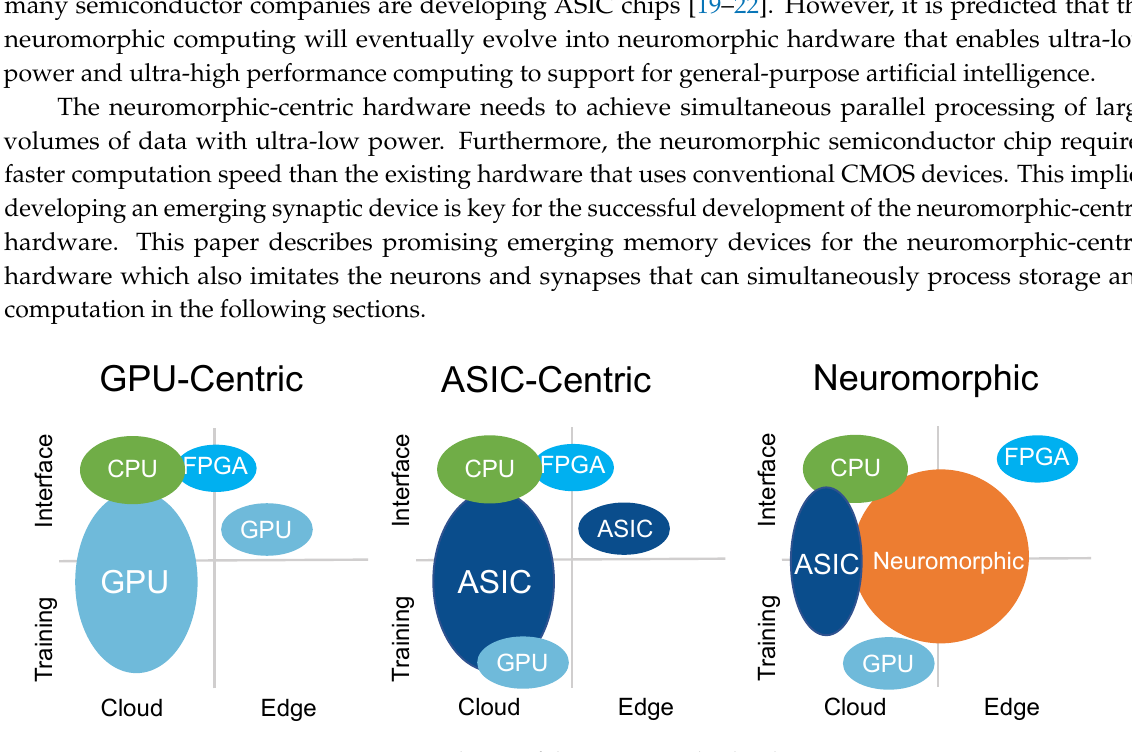
Figure 3. Evolution of the neuromorphic